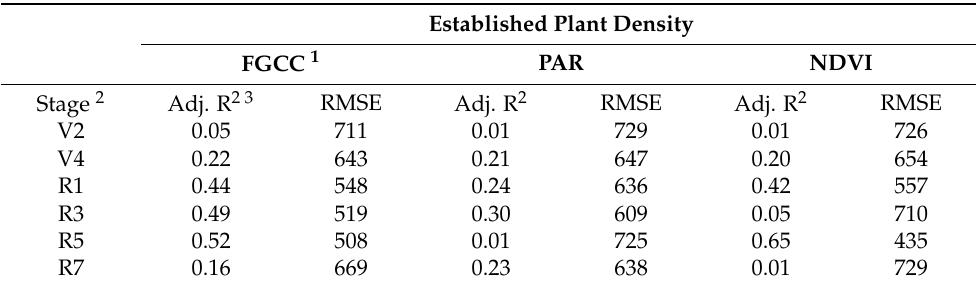
Table 6. Coefficients of determination (R 2 ) of soybean seed yield in relation to established plant density and green canopy cover, light interception, or vegetative index sampled over soybean growth stages for Casselton, Prosper, and Fargo, North Dakota, USA, in 2019 and